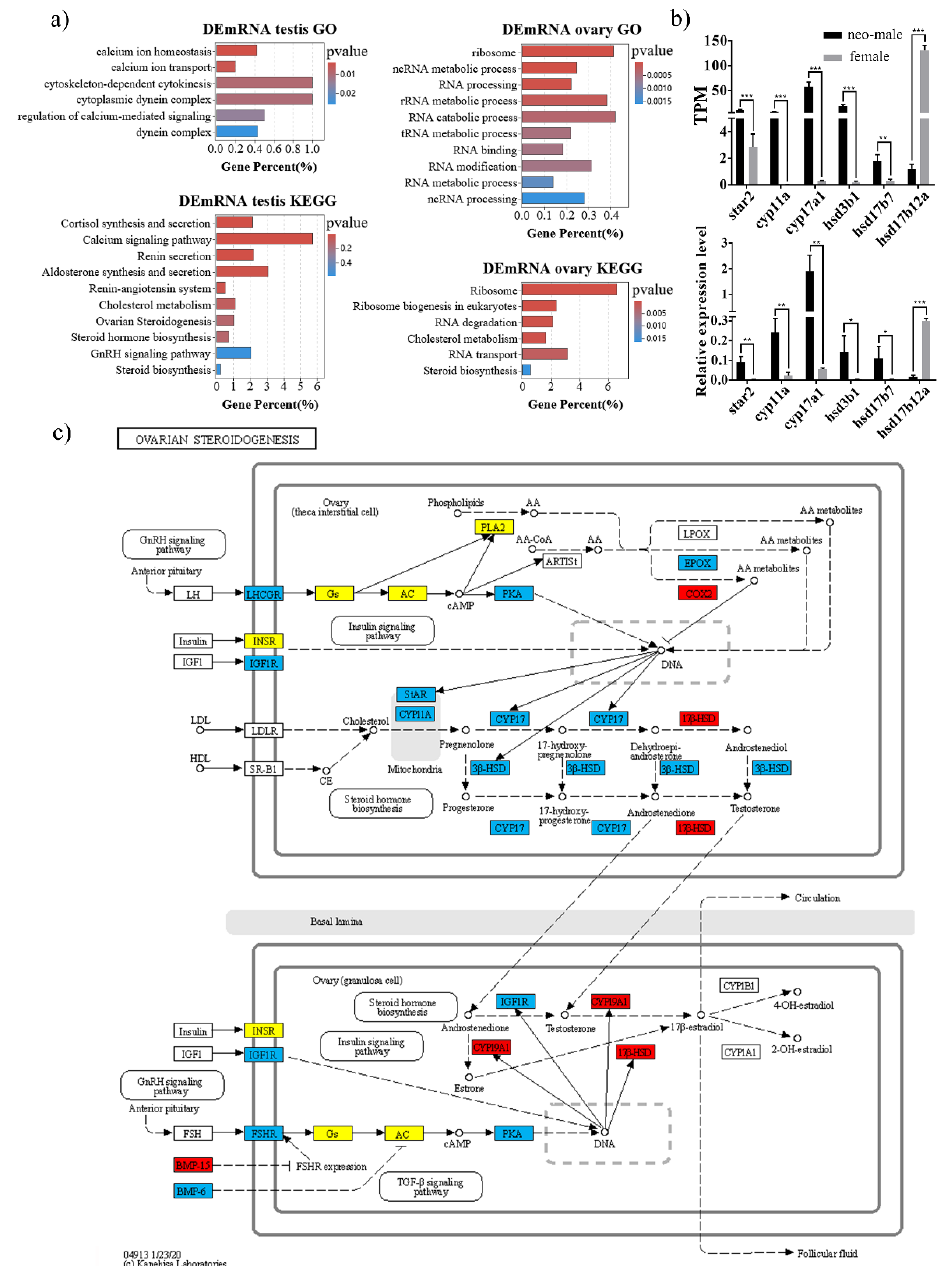
Figure 3. Functional annotation of DEmRNAs with steroid hormone biosynthesis pathway in P. olivaceus . ( a ) GO and KEGG enrichment of testis- and ovary-biased DEmRNAs; ( b ) differential expression of selected genes in ovarian steroidogenesis pathway by RNA-seq and qRT-PCR; ( c ) DEmRNAs in the steroidogenesis pathway. Blue boxes represent testis-biased genes, red boxes represent ovary-biased genes, and yellow boxes represent genes expressed in both testis and ovary. Data are shown as mean ± SD ( n = 3). Asterisks indicate statistical significance between groups (* p < 0.05; ** p < 0.01; *** p < 0.001).